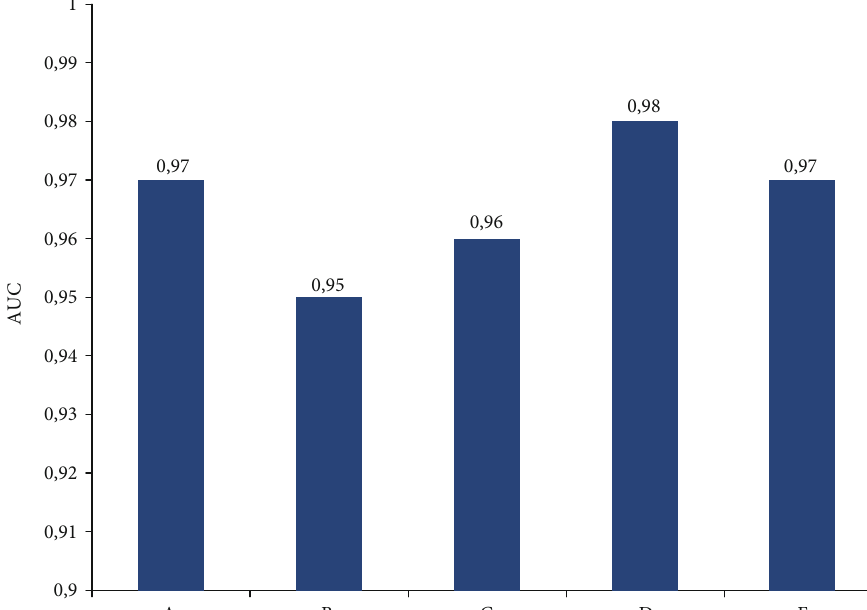
Figure 7: AUC based on fi ve random cytokines commonly expressed in serum generated by gNB models to diagnose MS. Serum common cytokines dataset consists of ten cytokines (IL-1 α , IL-4, IL-18, INF γ , CCL7, CCL27, LIF, M- CSF, SCF, and TNF α ). A: (IL-18, CCL27, INF-, LIF, and TNF α ); B: (IL-4, CCL7, CCL27, SCF, and TNF α ); C: (IL-4, IL-18, CCL27, SCF, and TNF α ); D: (CCL7, CCL27, INF- γ , M-CSF, and TNF- α ); and E (IL-4, IL-18, INF- γ , LIF, and SCF) are datasets which are generated by considering fi ve random cytokines. AUC is the average of 15